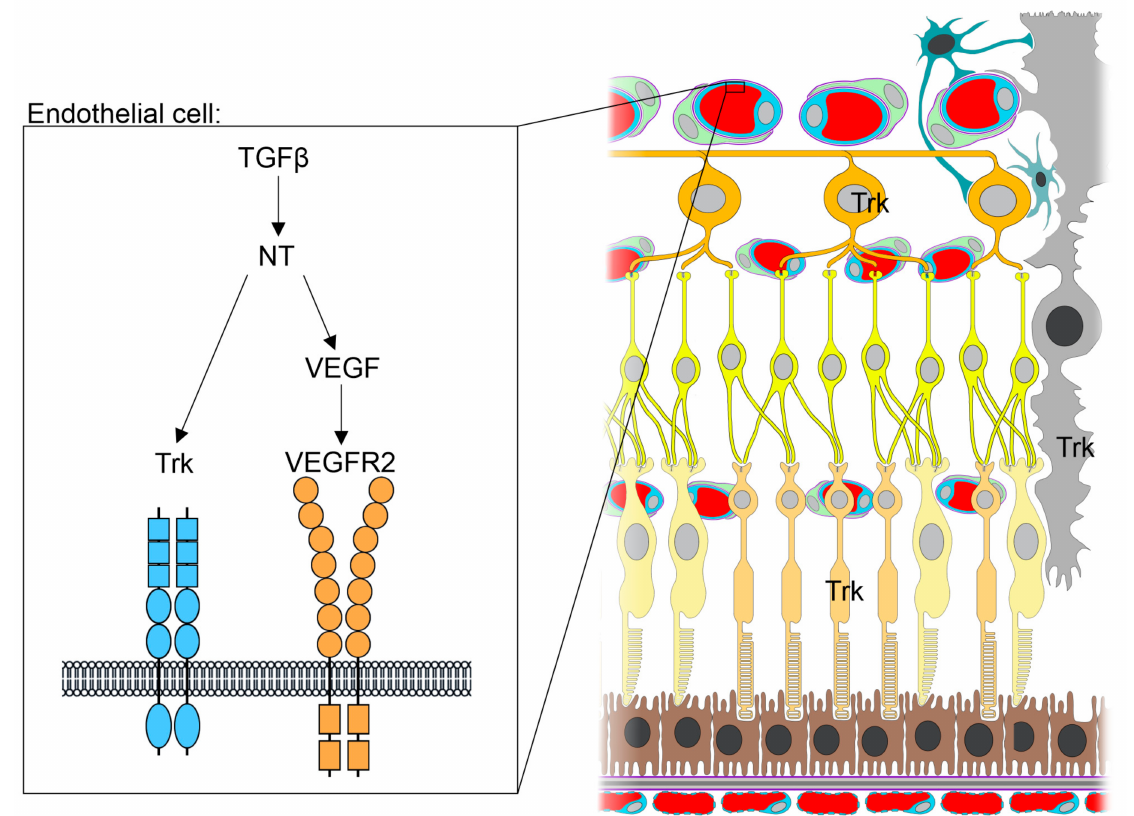
Figure 3. Angiogenic properties of neurotrophin and TGF β signaling. Scheme showing the interplay of neurotrophins, TGF β signaling, and endothelial cells in the retina. TGF β mediates upregulation of neurotrophins in the retina, which promote angiogenesis either by direct binding to Trk receptors on endothelial cells, or by inducing VEGF expression and subsequent activation of VEGFR2. TGF β = transforming growth factor β , VEGF = vascular endothelial growth factor, VEGFR2 = vascular endothelial growth factor receptor 2, Trk = tropomyosin receptor